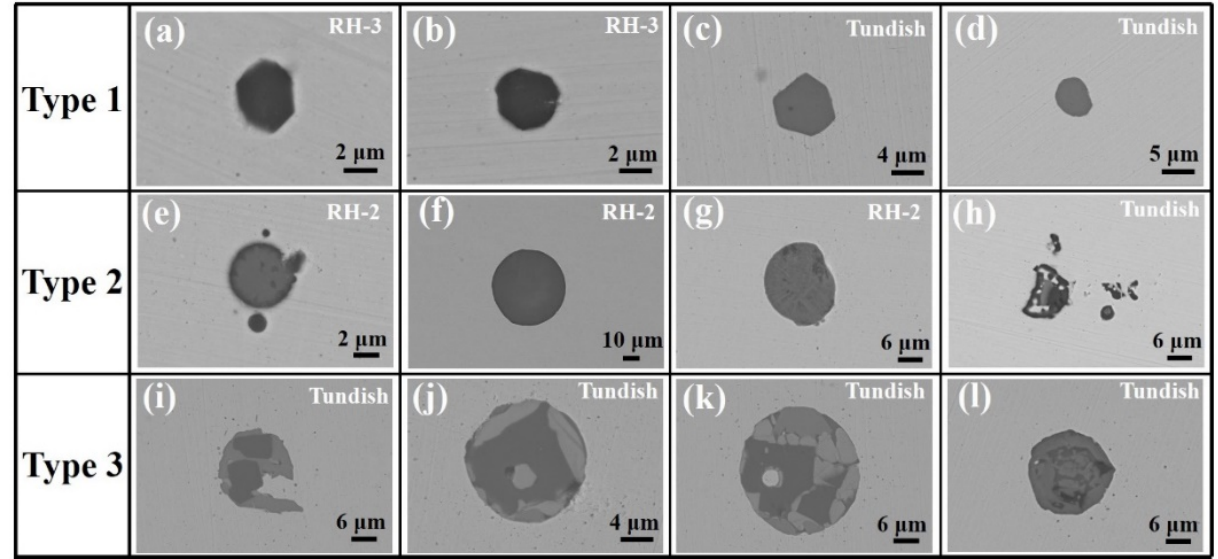
Figure 8. Morphologies of Al 2 O 3 ·TiO x inclusions during RH treatment and tundish processes. ( a – d ) Type 1 of Al 2 O 3 ·TiO x inclusions, ( e – h ) Type 2 of Al 2 O 3 ·TiO x inclusions, ( i – l ) Type 3 of Al 2 O 3 ·TiO x inclusions.